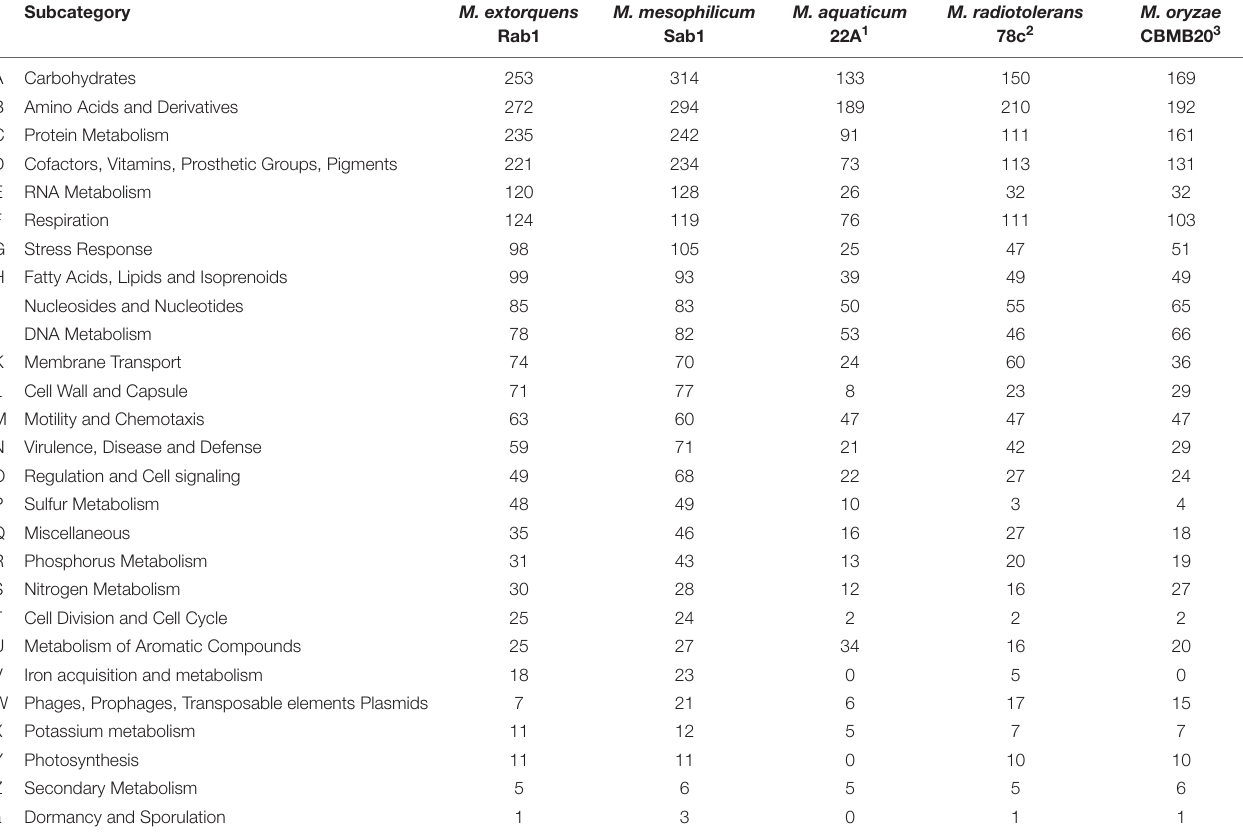
TABLE 2 | Detailed feature count for each microorganism per subcategory according to the SEED database after annotation using RAST (Aziz et al., 2008).